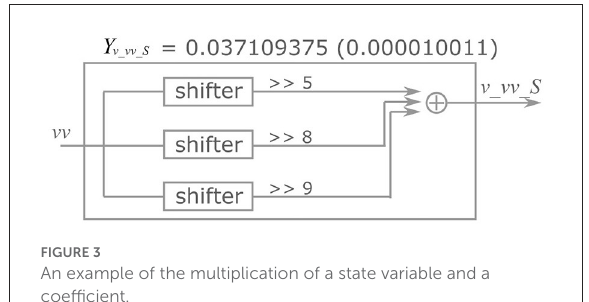
FIGURE3 An example of the multiplication of a state variable and a